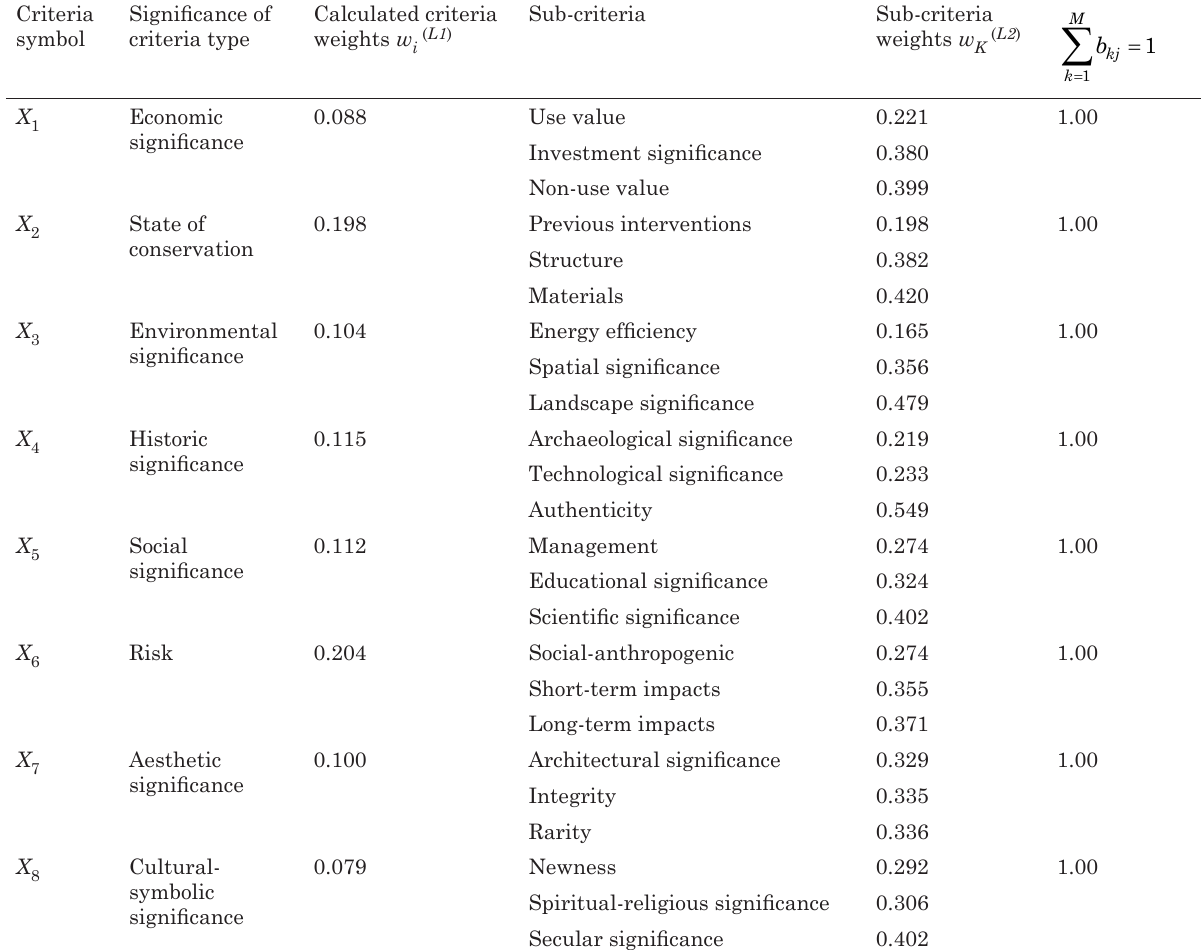
Table 6. The relative importance of the criteria and sub-criteria weights by applying AHP method Criteria